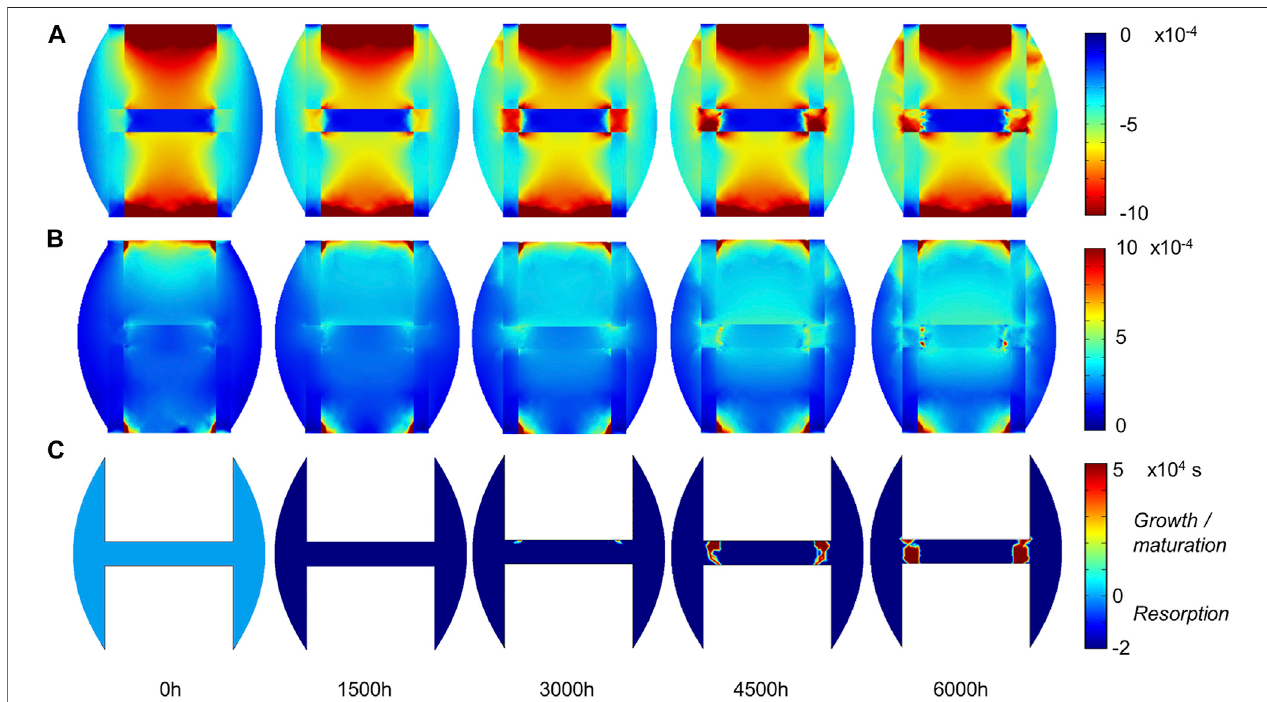
FIGURE 8 | Sheep fracture tissue mechano-sensation in mid-sagittal plane: (A) minimal principal strain. ε III ; (B) maximal principal strain ε I ; (C) bone-speci fi c strain responsefunction(restrictedtoitsactivationrange).Othertissue-speci fi cstrainresponsefunctionswerenotplotted,astheywereconstantlyanduniformlyequaltotheir minimal value (thus leading to